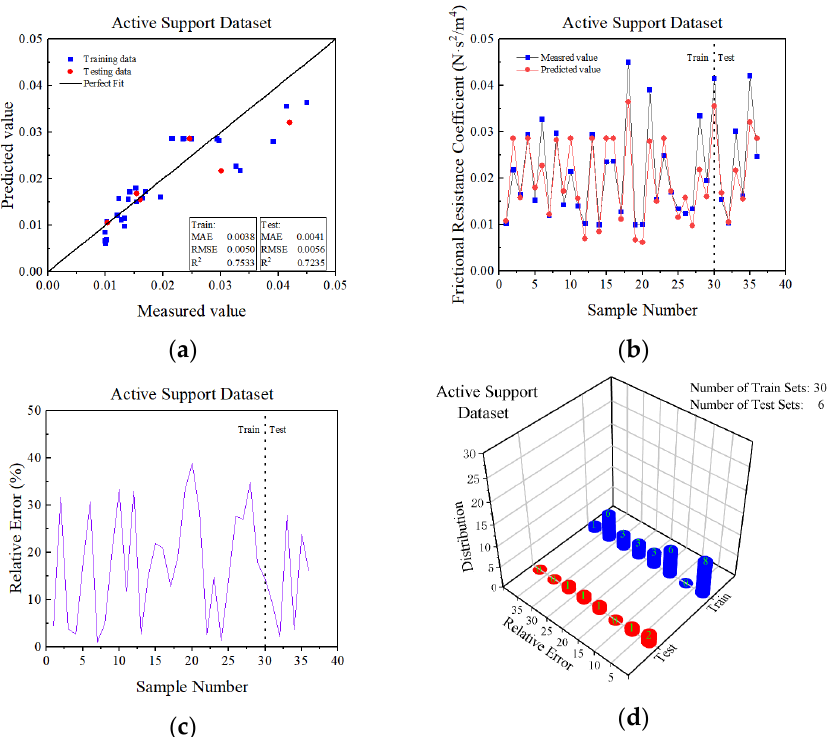
Figure 13. The active support BP model prediction results. ( a ) Correlation evaluation of the measured and predicted values of α; ( b ) curves of the measured and predicted values of the samples; ( c ) sample prediction error curve; ( d ) sample error frequency distribution.